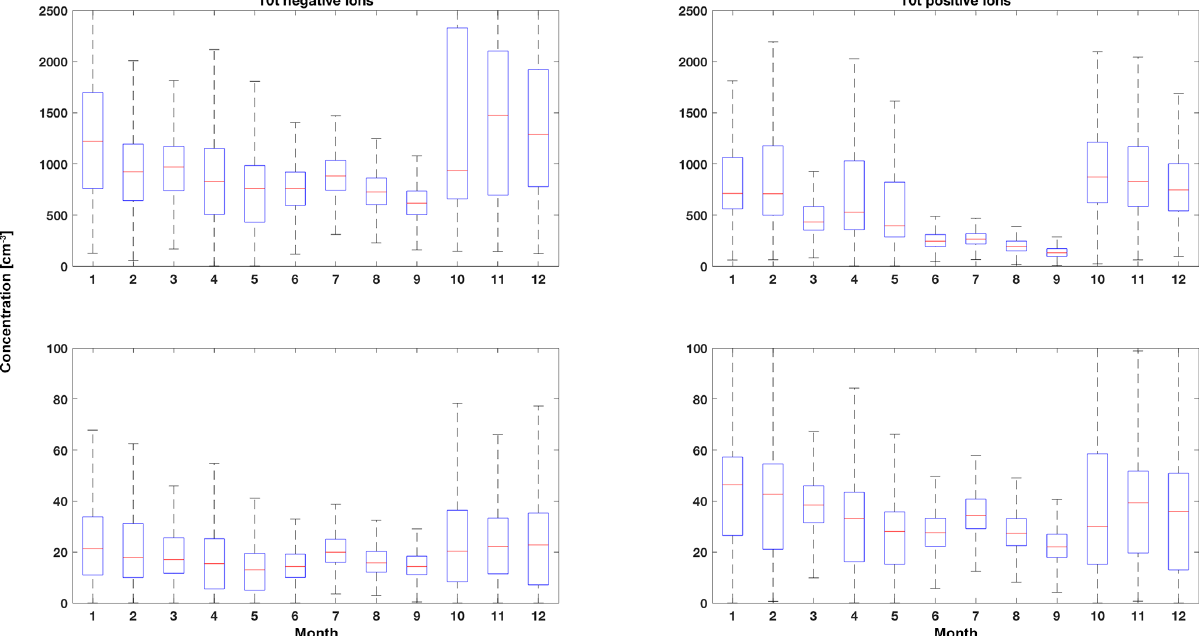
Figure 2. The median annual variations for positive and negative cluster (0.8–2nm) and intermediate (2–4nm) ions from the site inside the rainforest are shown. The boxes show the 25th–75th percentile and the whiskers are 1 . 5 × IQR (interquartile range); data points beyond the whiskers are considered